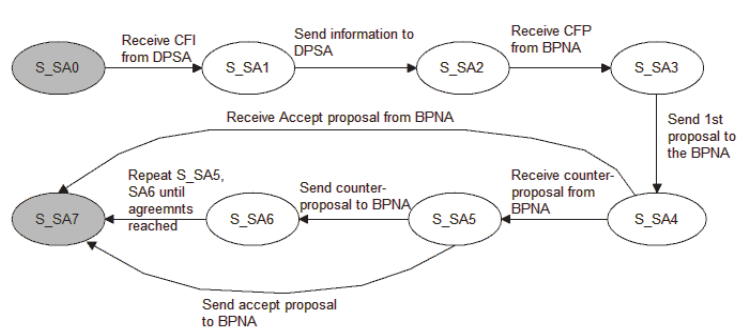
Fig. 8. State transition diagram of the